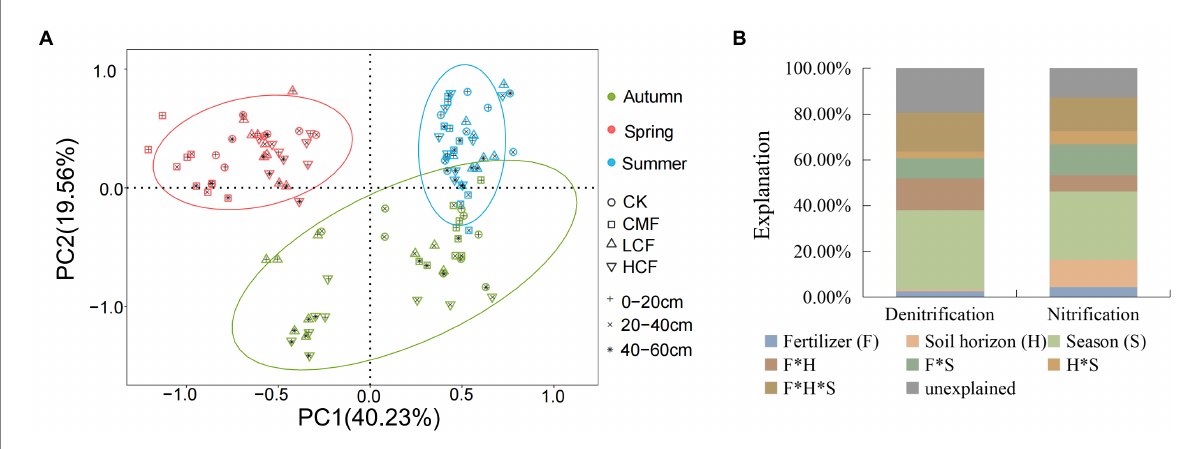
FIGURE 3 Comparison of individual and interactive effects of fertilization, soil horizon, and season on active N-cycling microorganisms. (A) Principal component analysis (PCA) of active N-cycling microorganisms. (B) Permutational multivariate ANOVA (PERMANOVA) of nitrifiers and denitrifiers. CK, control without fertilizers; LCF, low N chemical fertilizer; HCF, high N chemical fertilizer; and CMF, manure fertilizer combined with N chemical